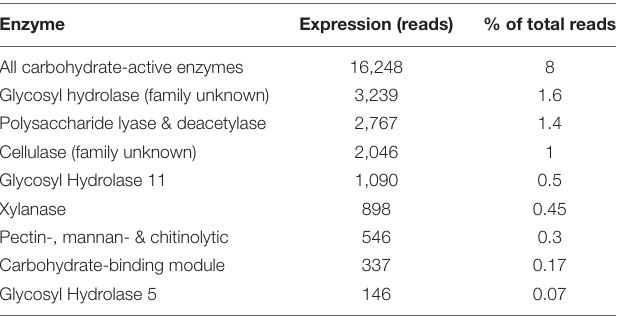
TABLE 2 | Expression (number of reads) and percentage of total reads per type and family of carbohydrate active